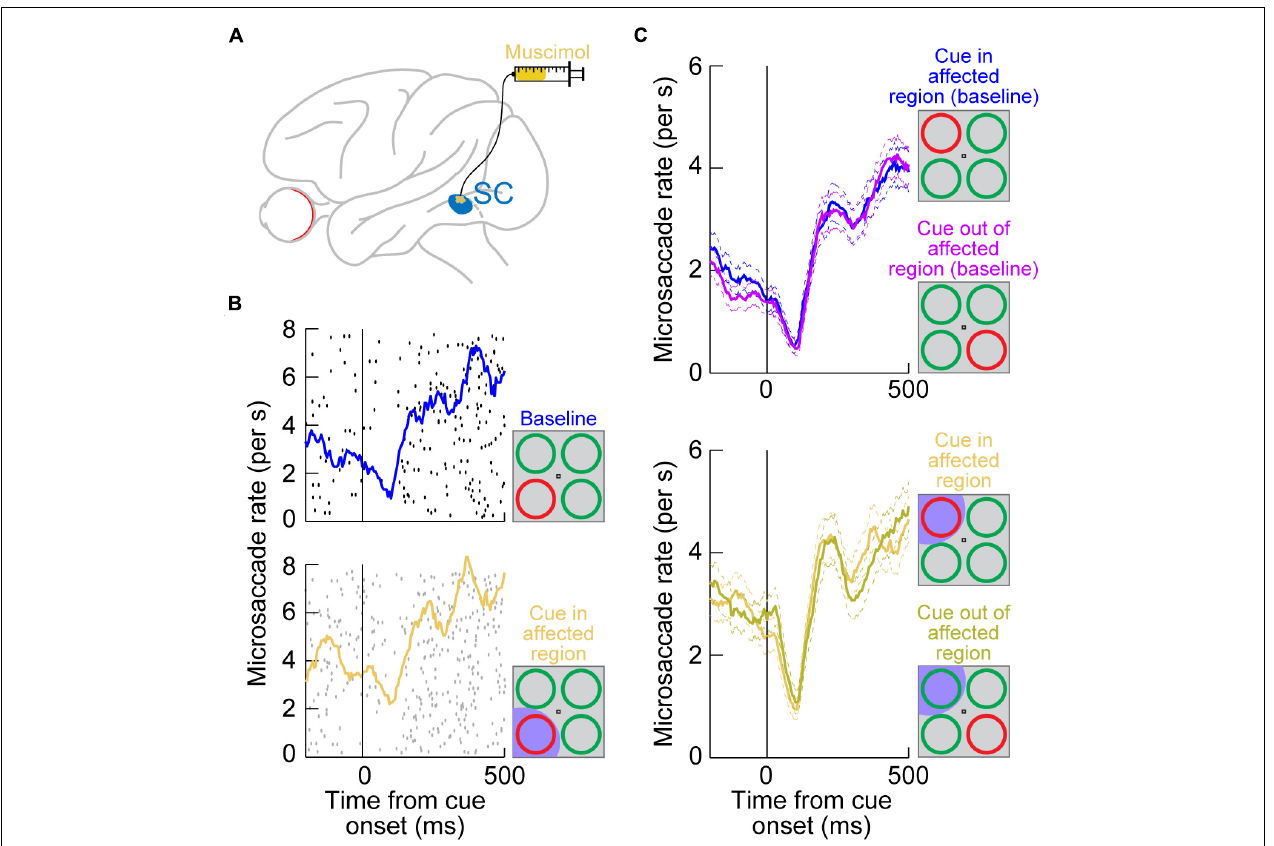
FIGURE 2 | Reversible inactivation of the SC does not influence microsaccadic rate modulations after peripheral cue onsets. (A) Injection of the GABA agonist muscimol into a restricted region of the SC topographic map. The injection was intended to affect only an extra-foveal representation of the SC, such that microsaccade-related neurons in the foveal zone (Hafed et al., 2009; Hafed and Krauzlis, 2012; Chen et al., 2019; Willeke et al., 2019) were largely not affected. Rather, it was the representation of the location of a peripheral visual cue that was targeted [see the bottom schematic in (B) ] (Hafed et al., 2013). (B) Microsaccade rate in a cueing task from a sample session before SC inactivation (top) and after inactivation (bottom). The task consisted of the onset of a color singleton ring as the cue in an attentional task (Lovejoy and Krauzlis, 2010); see schematics on the right. In this session, the cue appeared in the bottom left quadrant of the display relative to fixation position. Each black or gray dot indicates the onset time of a microsaccade relative to cue onset (different rows represent different trials), and all microsaccades toward or opposite the cue quadrant are shown. The colored curves show microsaccade rate estimates in each block. In the bottom panel, the SC representation of the lower left quadrant of the display was inactivated (shaded in the bottom schematic); that is, it was the representation of the singleton cue that was affected. Microsaccadic inhibition happened regardless of SC inactivation, and the overall rate modulation was similar with or without SC inactivation (Hafed et al., 2013). (C) Microsaccade rate from the same monkey across all sessions. The top panel shows rate modulations without SC inactivation when the cue was either in or outside of the region to be targeted by muscimol (opposite quadrants; see schematic insets on the right). Microsaccade rate modulations were identical, with strong microsaccadic inhibition shortly after cue onset. In the bottom panel, data from the same sessions are shown, but now with the SC inactivated in one quadrant of the visual display. Whether the cue was placed in the affected quadrant or opposite from it (see schematic insets on the right), microsaccadic rate modulations were similar. (B,C) Adapted with permission from Hafed et al.